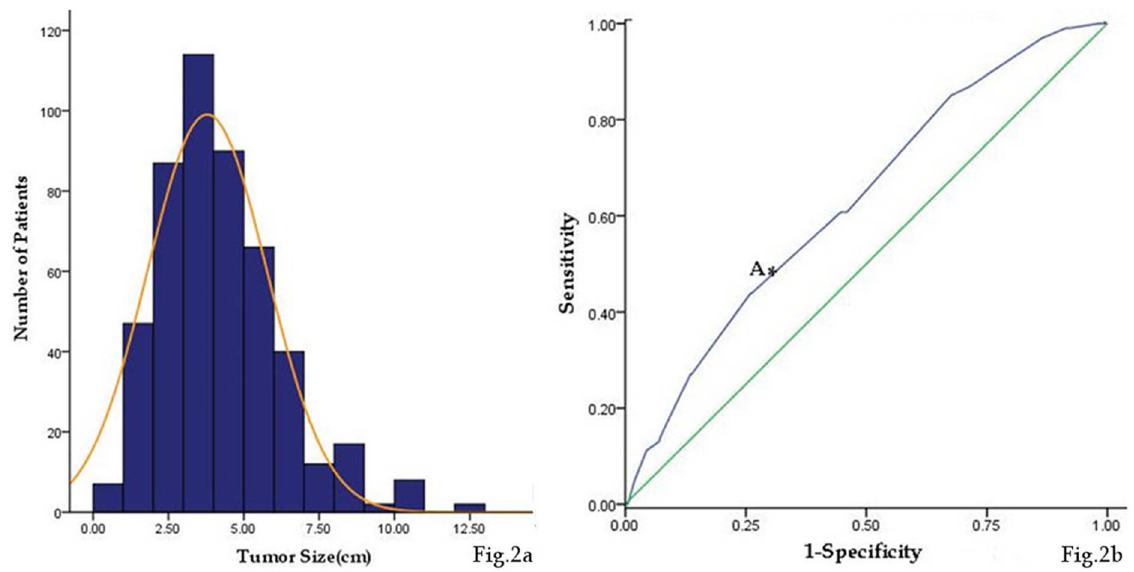
Figure 2. Distribution and the cutoff value of tumor size. (a) Histogram of the number of patients with regard to tumor size. (b) Receiver- operating characteristic curve (A: Shows sensitivity and specificity for a tumor size cutoff value of 4.75 cm were 53.9% and 73.2%, respectively).